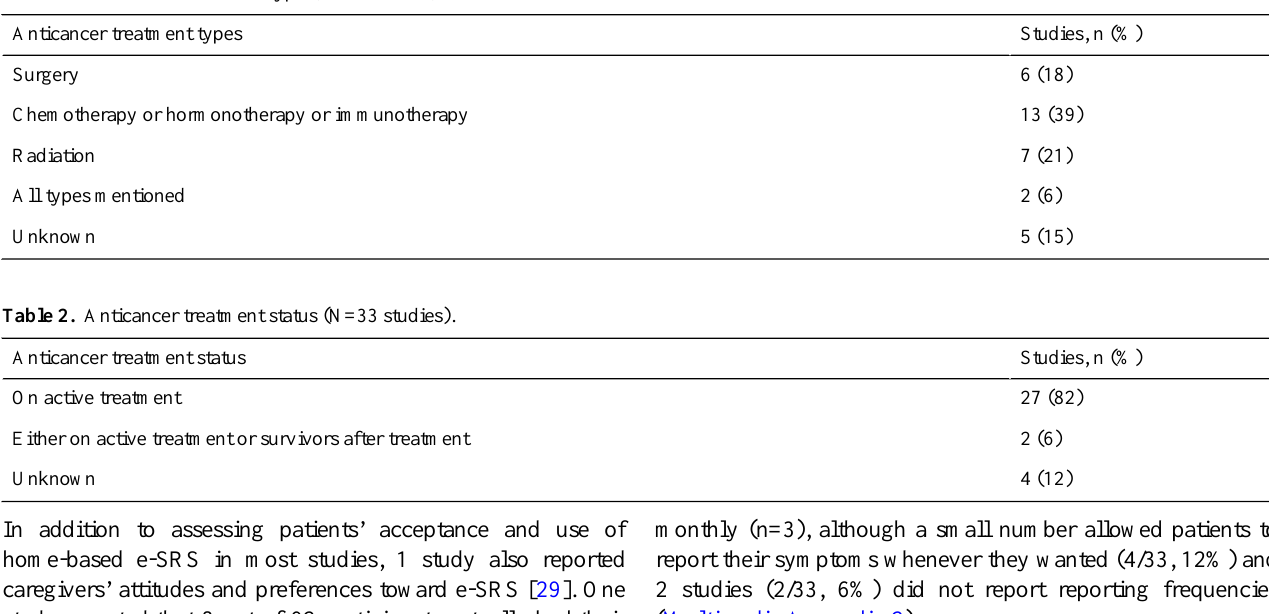
Table 1. Anticancer treatment type (N=33 studies).